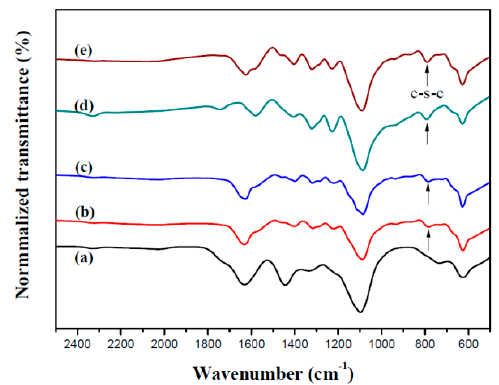
Figure 2. FT-IR spectra of ( a ) PdCz; ( b ) P(dCz2- co -dTC1); ( c ) P(dCz2- co -dTC2); ( d ) P(dCz1- co -dTC2) and ( e ) PdTC.